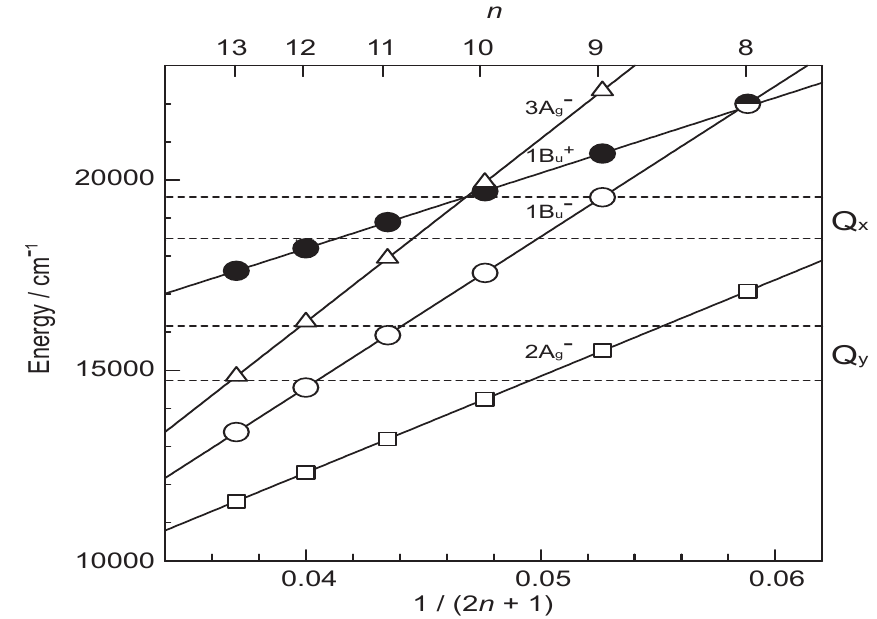
Figure 15. The energies of the optically-allowed 1B 1B u– and 3A g– states of Cars and those of the Q chain Cars ( n = 8 and 9) have a better chance of singlet-energy transfer from Car to Phe a ) (reprinted from [7] with permission of MDPI (1B u+ → Q x